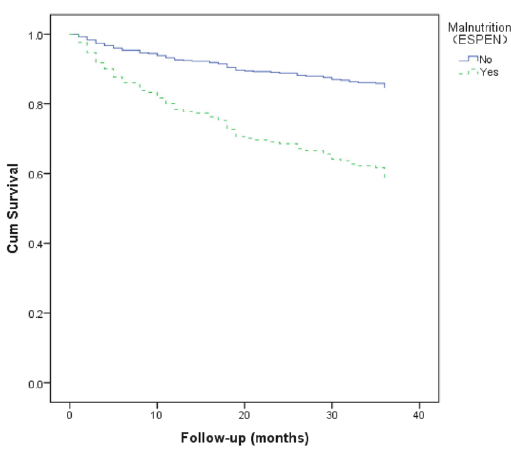
Figure 4. Survival curves of the study population according to malnutrition ESPEN at baseline. Survival curves significantly differed in the log-rank test (p <